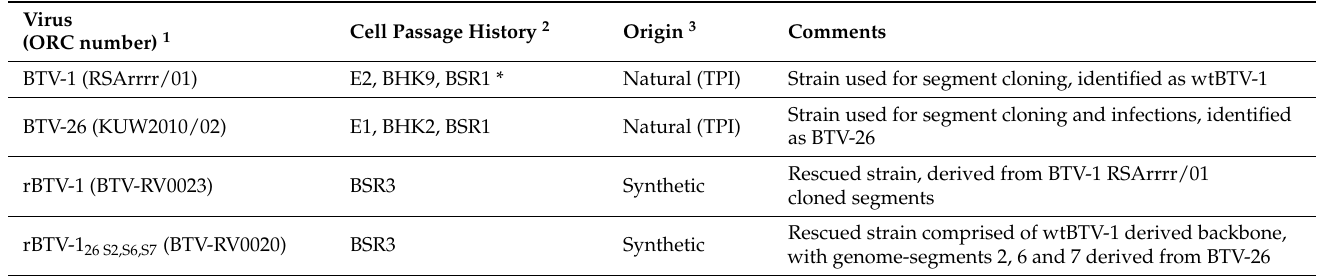
Table 1. List of